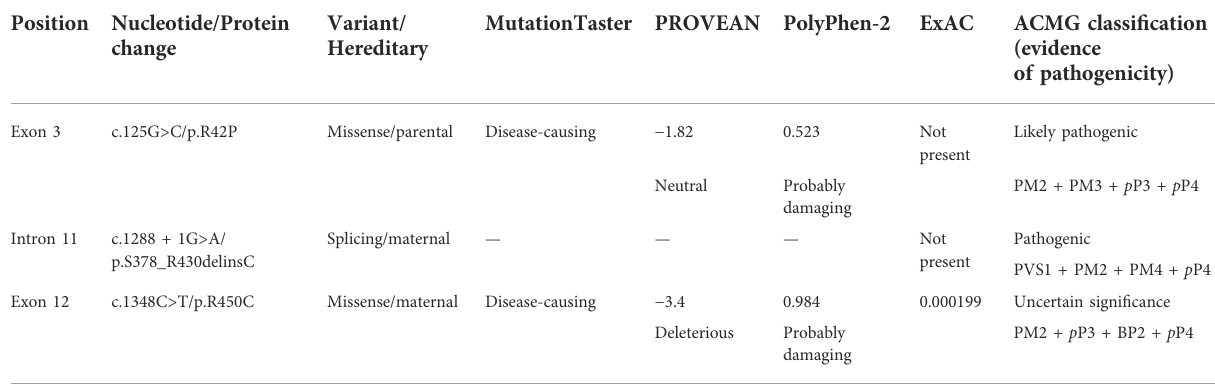
TABLE 1 Summary of the patient ’ s three LAMB3 variants and predicted functional change